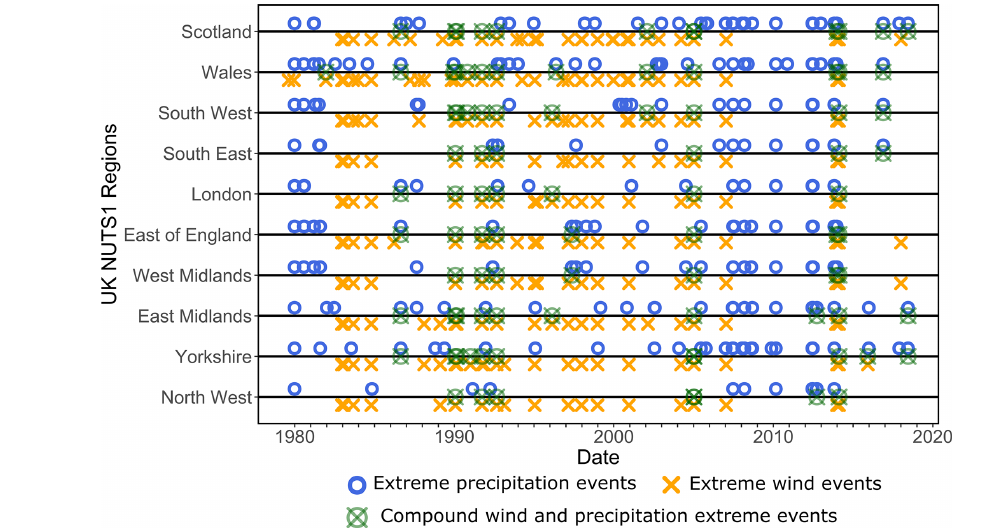
Figure 10. Timeline of 157 events in our Great Britain Significant Weather Events Catalogue 1979–2019 (Supplement 4) used to assess the detection abilities of the SI–CH methodology for the 11 NUTS1 regions of Great Britain. Significant events are considered to be precipitation (96 events, heavyweight blue circles) or wind (61 events, heavyweight orange crosses). Of the 157 events in the significant weather events catalogue (Supplement 4), 24 can be considered compound hazard events (lightweight green circle overlain by a cross) as given in the